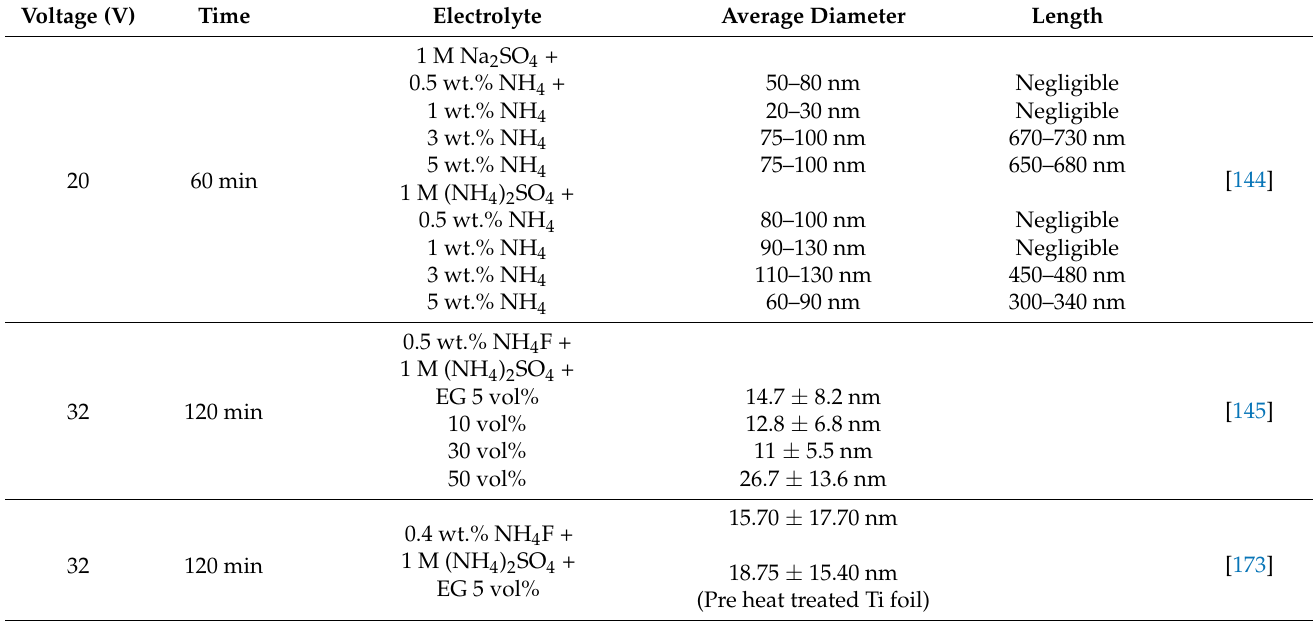
Table 2. Various dimensions of anodic nanotubes found by altering the anodization parameters. Voltage (V) Time Electrolyte Average